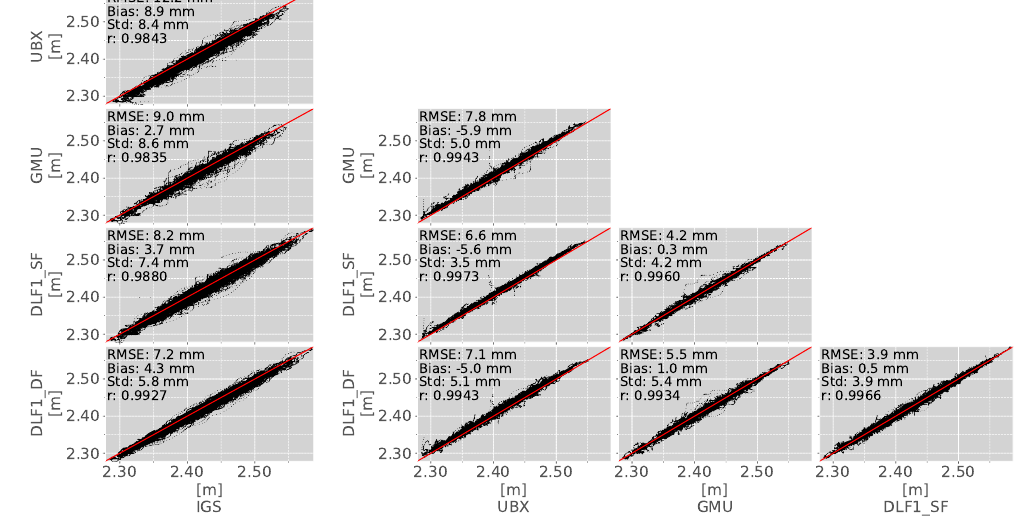
Figure 3. ZTD scatter plots of the IGS reference dataset, the dual-frequency PPP-processed DLF1 dataset (DLF1_DF), and the SEID-processed single-frequency data from UBX, GMU, and DLF1_SF utilizing the DPGA SEID reference network. The plots on the left depict the comparison of the goGPS estimations to the IGS reference dataset. The scatter plots on the right show the SEID and instrument errors. The observation period is from 1 January 2017 (DLF1_DF & DLF1_SF) and 1 September 2017 (GMU & UBX) until 31 December 2017. The solid red line depicts the regression